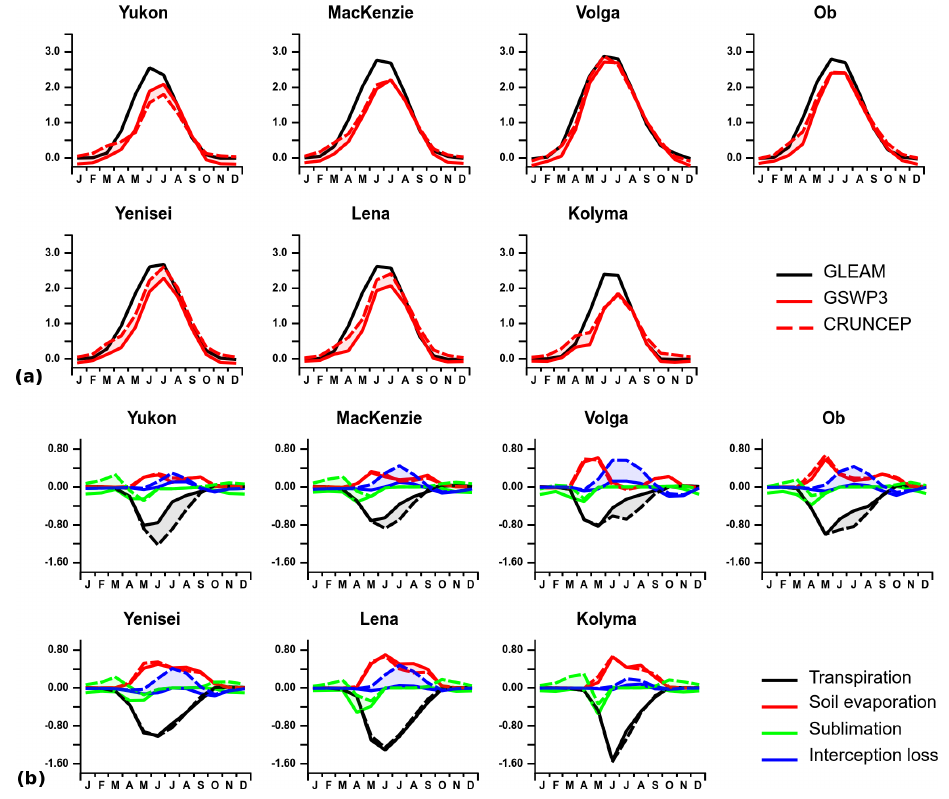
Figure 11. (a) Monthly mean seasonal evapotranspiration (mmd − 1 ) simulated with the two forcings compared to the GLEAM data-driven model over the seven basins (see Fig. 2b), averaged over the period 1981–2007. (b) Seasonal bias of ET components (mmd − 1 ) averaged over the same period, with the GSWP3 (solid line) and CRUNCEP (dashed line)